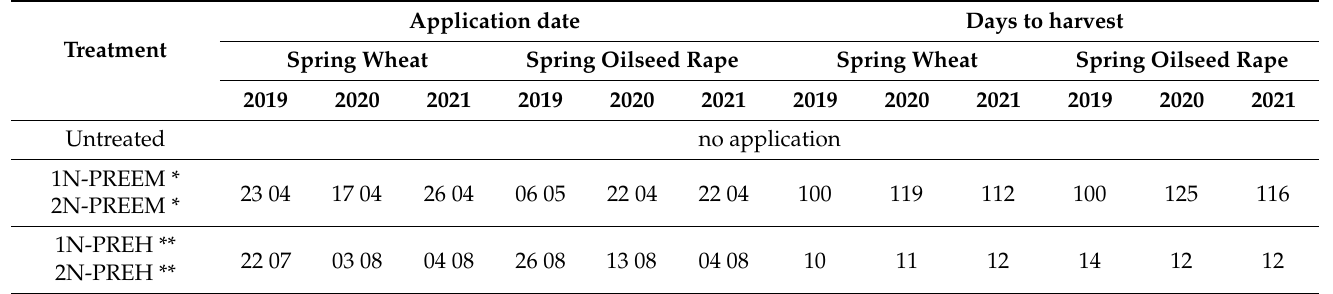
Table 6. Glyphosate application at pre-emergence and pre-harvest in spring wheat and spring oilseed rape, in